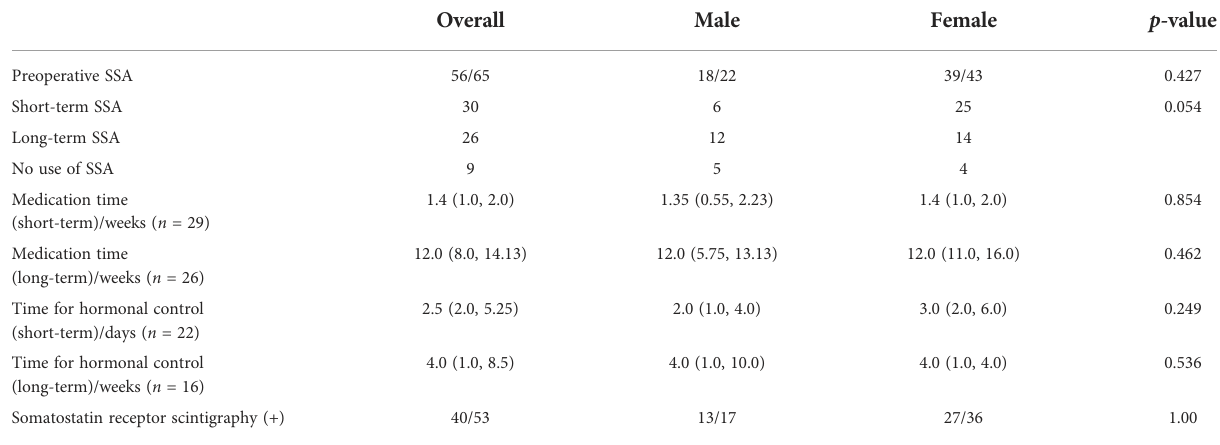
TABLE 2 Presurgical medication and somatostatin receptor